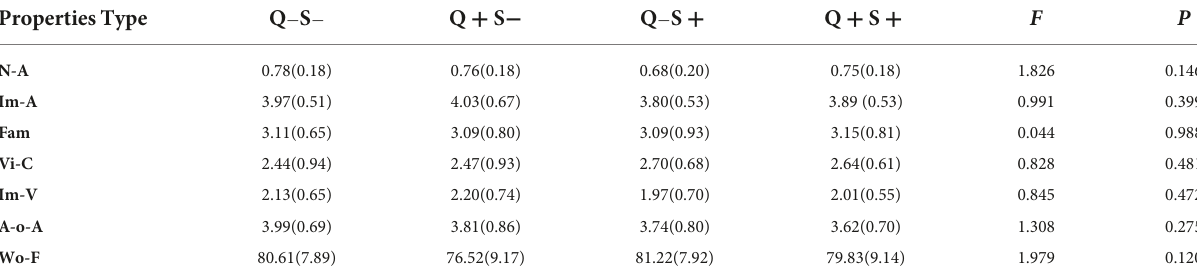
TABLE 1 Mean (SD) scores for the list of 132 pictures; 33 singular-inanimate (Q − S − ), 33 plural–inanimate (Q + S − ), 33 singular-animate (Q − S + ), and 33 plural-animate (Q + S +